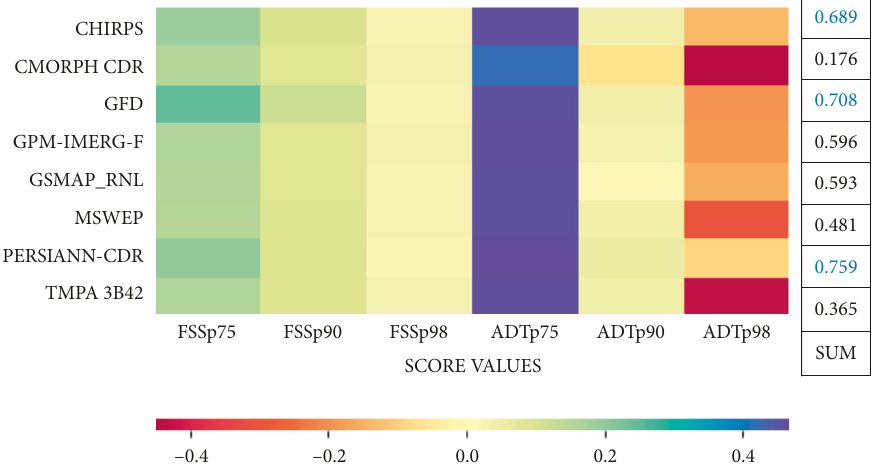
Figure 4: Heatmap of extreme value representation performance metric with Table 2: SR score comparison based on dataset types.